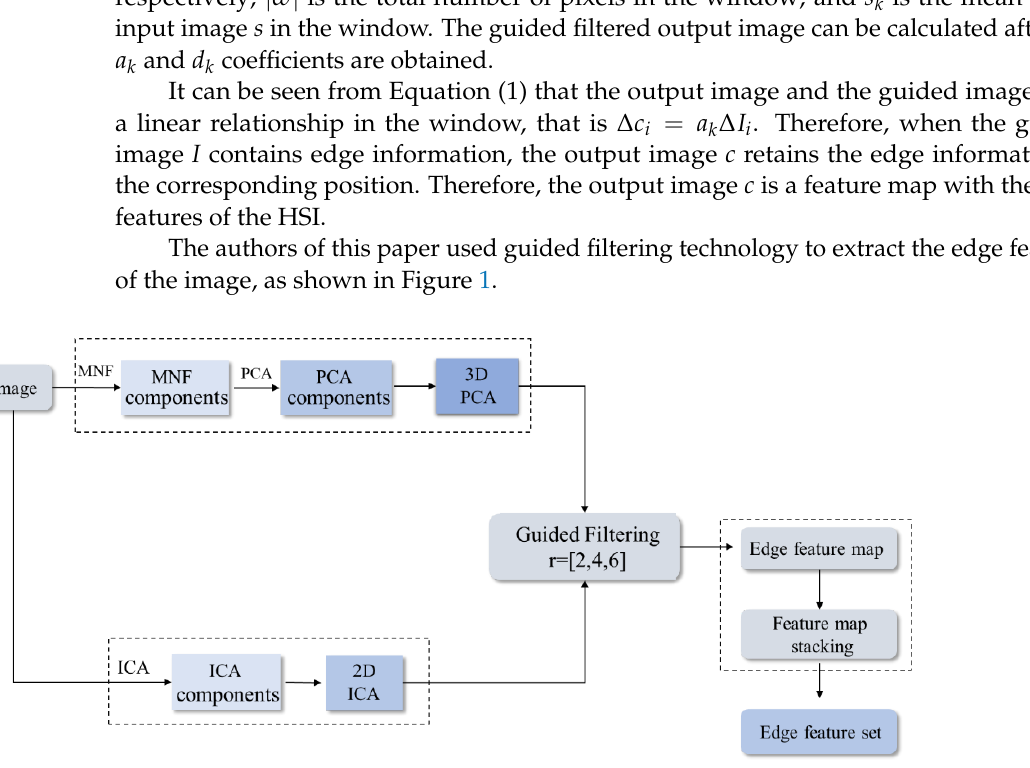
Figure 1. Flow chart of guided filtering to extract edge features. PCA: principal component analysis; ICA: independent component analysis; MNF: minimum noise fraction rotation.